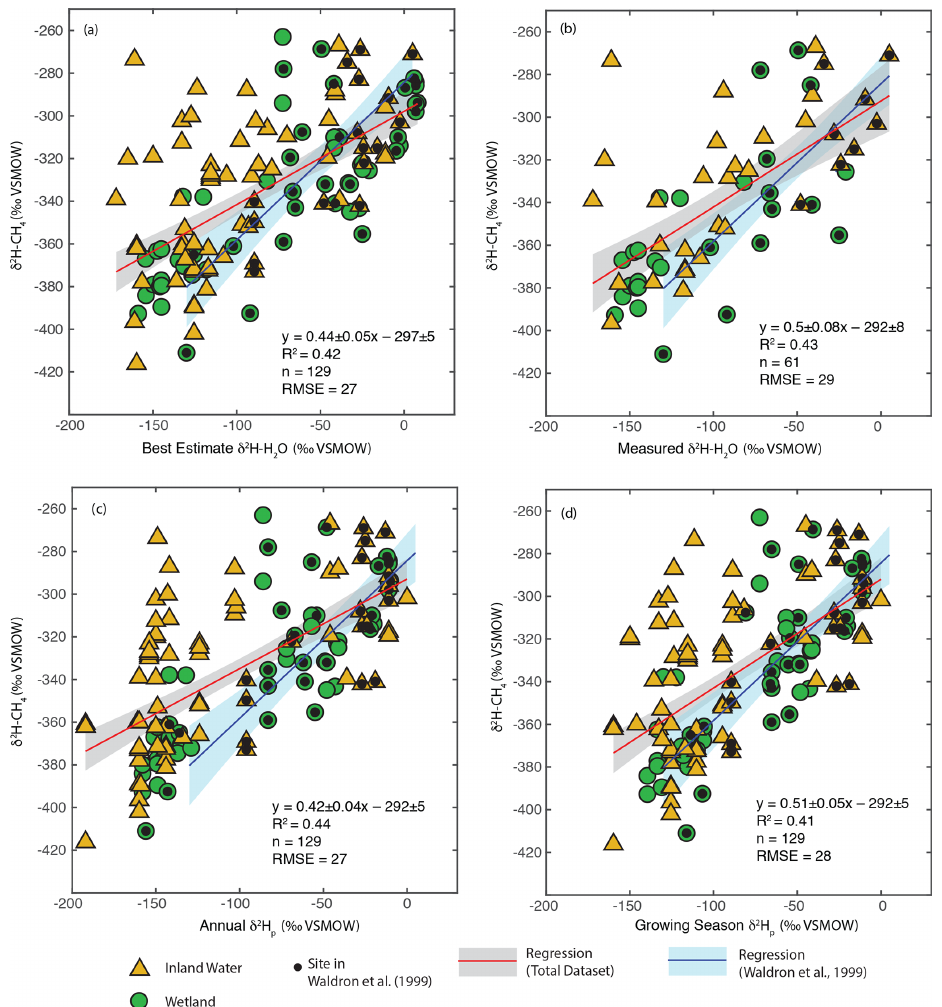
Figure 3. Scatter plots of δ 2 H–CH 4 vs. (a) best-estimate δ 2 H–H 2 O, (b) measured δ 2 H–H 2 O, (c) annual δ 2 H p , and (d) growing season δ 2 H p . Sites that were included in the analysis of Waldron et al. (1999a) are indicated. The regression relationship for the total dataset in each plot is shown by the red line, with its 95% confidence interval (grey envelope). The regression relationship and confidence interval for the dataset of Waldron et al. (1999a) are shown in blue. Uncertainties for reported regression relationships are standard